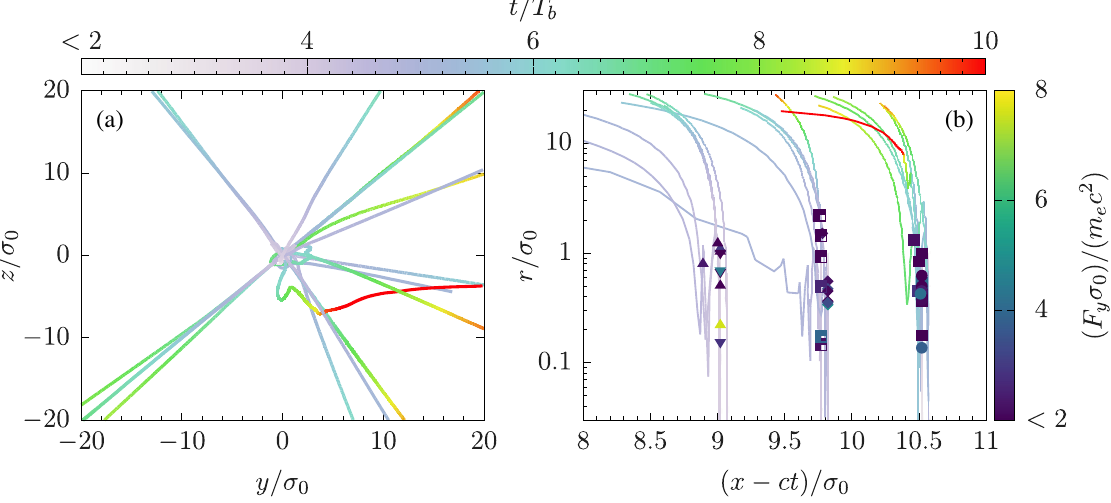
FIG. 8. The 3D PIC simulation result of an electron bunch propagating in a vacuum. Fields are calculated with the Yee solver and RR force is enabled. Here, 18 different particles have been tracked and the transverse force in their cell documented. (a) shows the particle displacement in the x and y direction. (b) shows the tracked particles in a x − r − F y plot. The trajectories are colored according to the simulation time. The points at certain times are color coded according to the transverse force within the cell, where the particle is currently located. Only transverse force values bigger than 2 have been displayed. Forces are displayed for two particles, respectively, at initial positions of ð x − ct Þ = σ 0 ¼ 9 . 00 , ð x − ct Þ = σ 0 ¼ 9 . 75 , and ð x − ct Þ = σ 0 ¼ 10 . 50